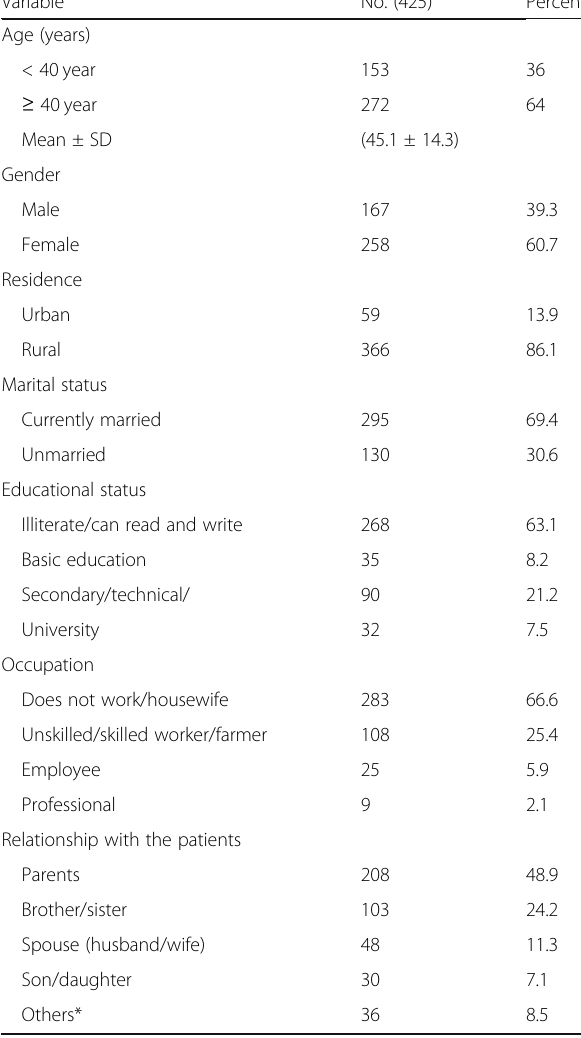
Table 1 Characteristics of the studied caregivers at Assiut